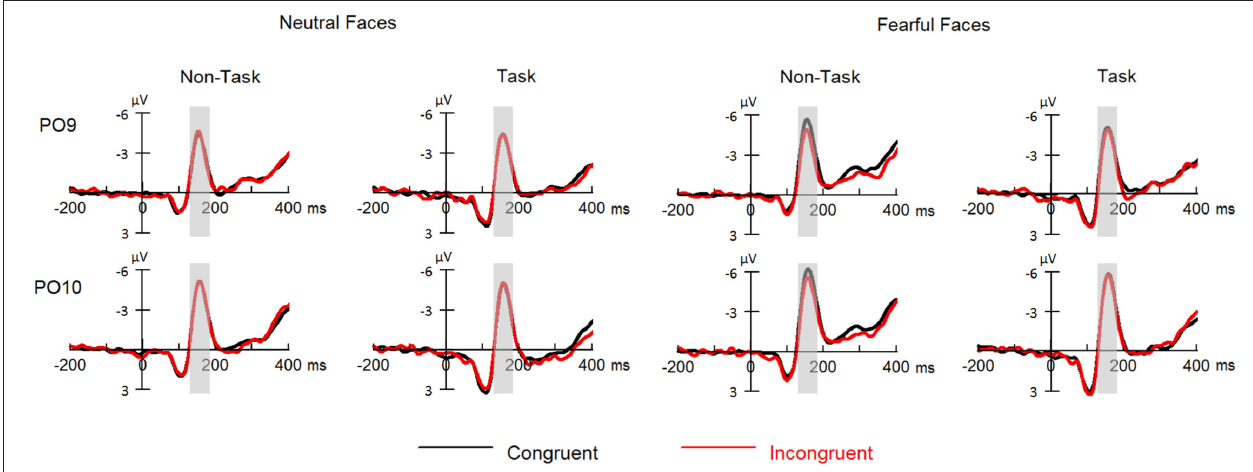
FIGURE 3 | ERPs at parietal- occipital electrodes (PO9 and PO10) for all the experimental conditions. Shaded areas correspond to the analysis window for the N170 (130–180ms).